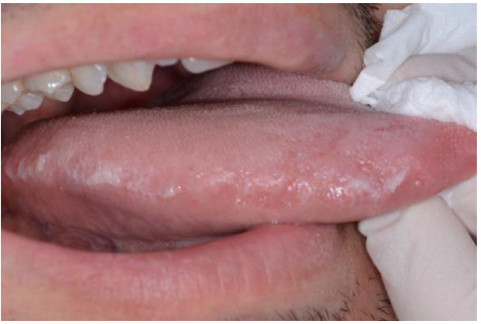
Figure 4. Hairy leukoplakia of the tongue margin associated to HBV infection.